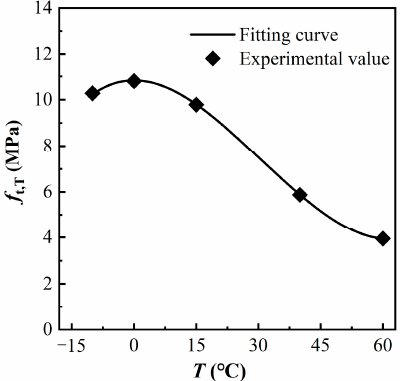
Figure 14. Relationship between tensile peak stress and